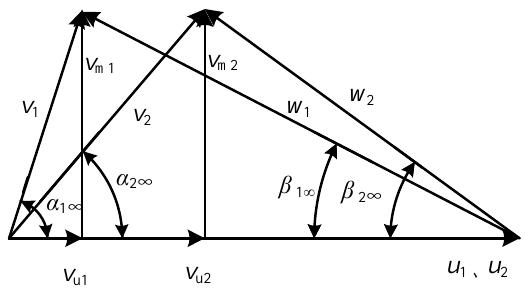
Figure 2. Velocity triangle of the rotor blade.